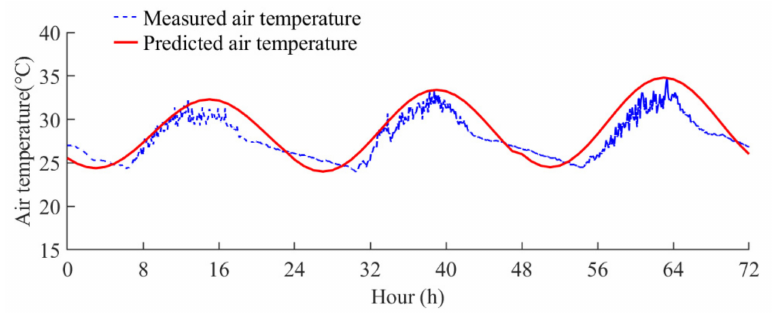
Figure 11. Comparison of the predicted and measured air